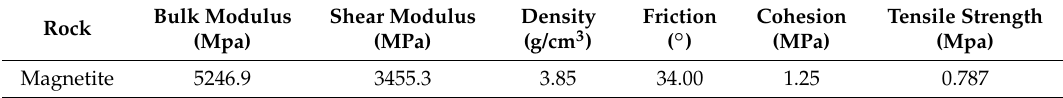
Table 1. Mechanical parameters of magnetite.